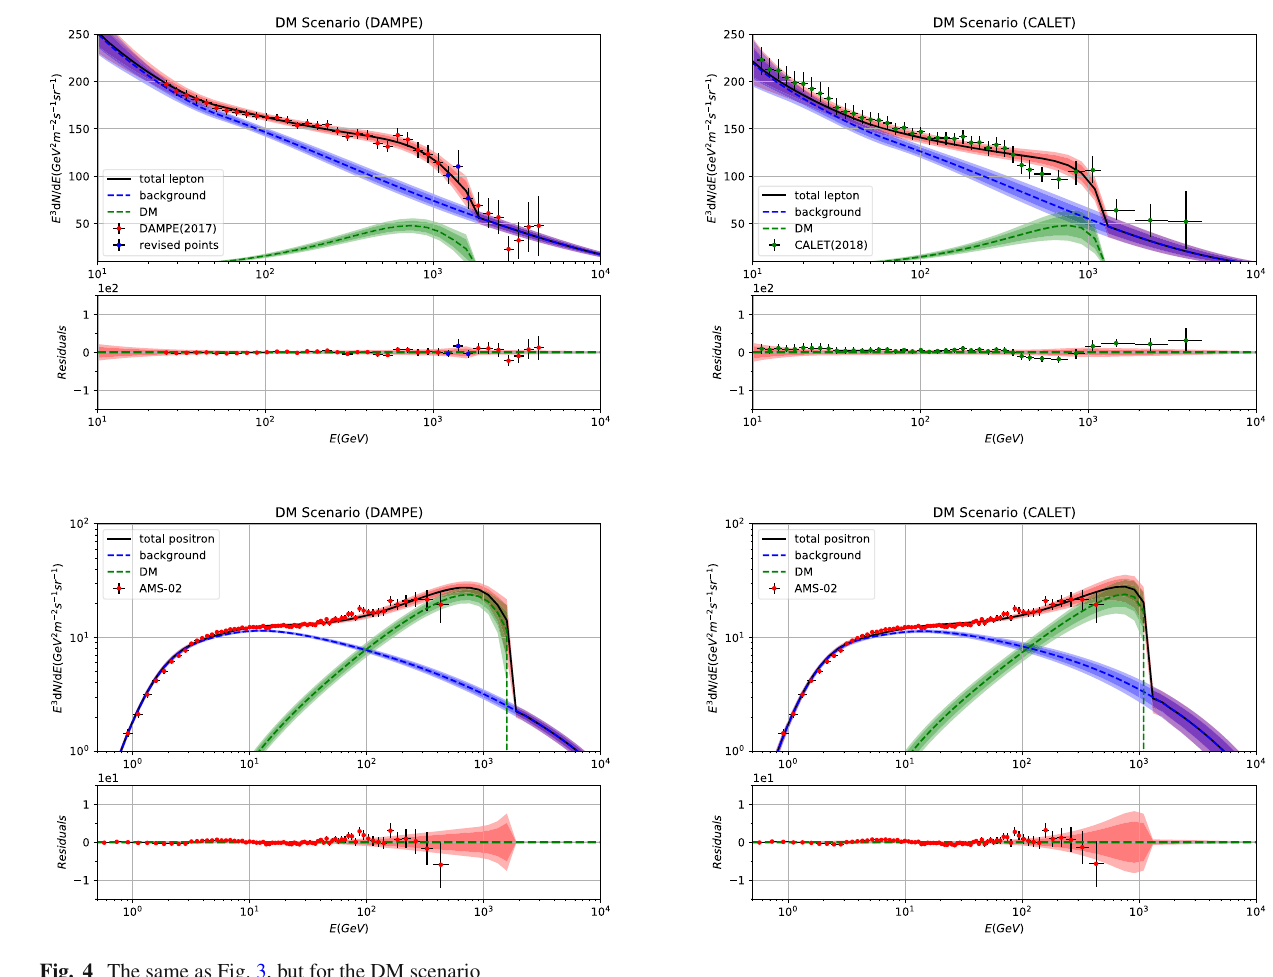
Fig. 4 The same as Fig. 3, but for the DM scenario